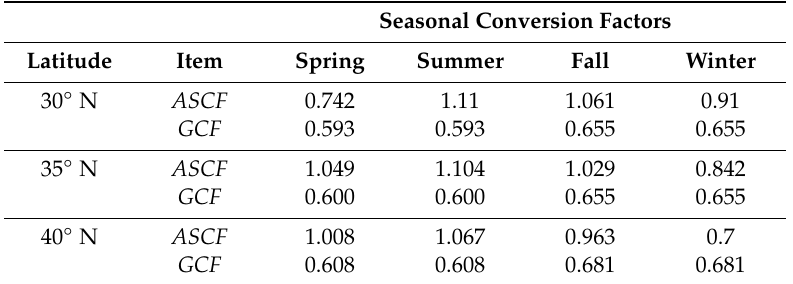
Table 1. Action spectrum conversion factor ( ASCF ) and geometric correction factor ( GCF )